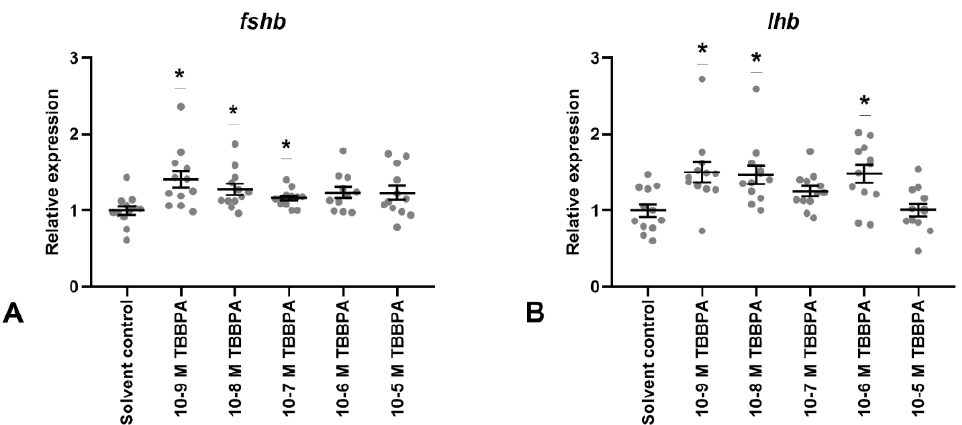
Figure 5. Gene expression of gonadotropin subunits ( FSHb ; ( A ), LHb ; ( B )) in Atlantic cod pituitary cells after 7 days of primary culture w / wo TBBPA added to the culture media for the last 72 h. Each data point represents the sample fold change relative to mean solvent control. For each column, the group mean ± SEM is indicated ( n = 11–12). Statistical significance (* p < 0.05) was assessed using the